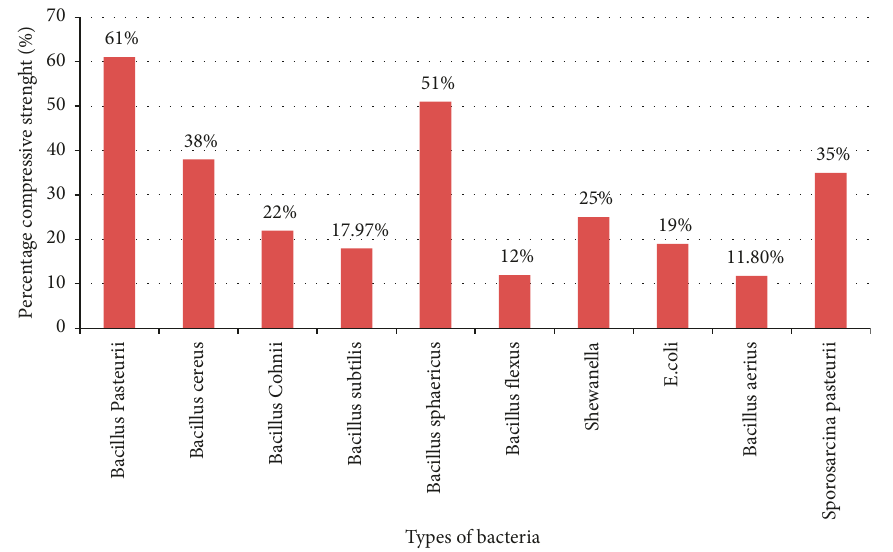
Figure 5: Compressive strength of mortar with different bacterial species by 10 5 cell/ml concentration [21]. Table 2: Compressive, tensile, and flexural strength of bacterial and conventional concrete in 7, 14, and 28 curing days with 10 5 cell/ml cell concentration